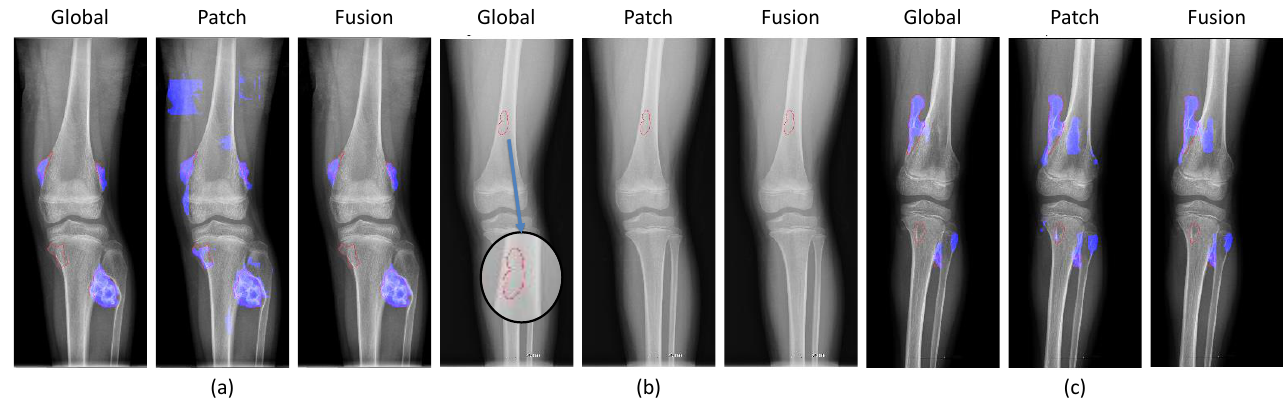
Figure 13. Failed cases of the fusion between global and patch-based models with ( a ) not enough tumor regions, ( b ) no tumors, and ( c ) not enough tumor and noise. (red line: ground-truth, blue region: tumor detection, blue arrow: zoom in the small ground-truth regions).